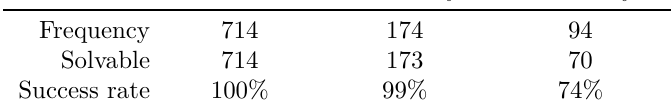
Table 5: The analogous statistics to those in Table 4 for κ = 25. For details on the table entries, see the caption for Table